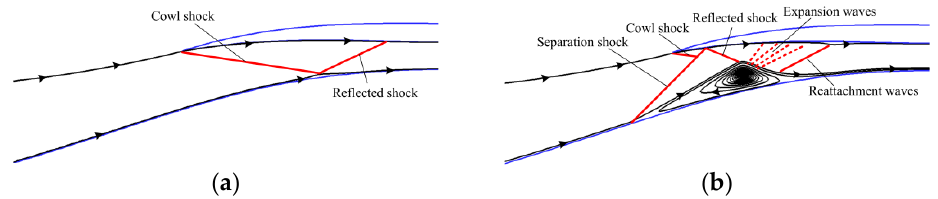
Figure 10. Structures of the two flow fields ( δ = 10°) at Ma = 4.3 for ( a ) Flow field A and ( b ) Flow field B.